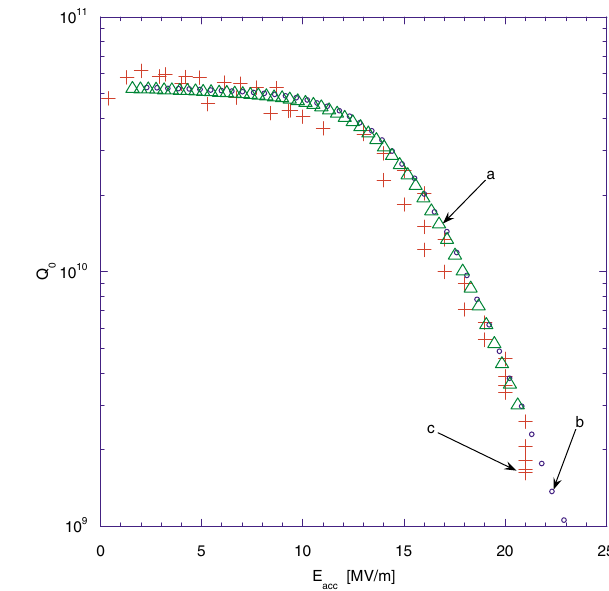
FIG. 13. (Color) Surface defect simulation for a 1500 MHz cavity. Curves are labeled as follows: ( a ) bath cooled, no surface defect; ( b ) bath cooled with surface defect; ( c ) five pipes ; (cid:15) 2 cm , surface coverage 38%, no defect; ( d ) same as ( c ) but with surface defect; ( e ) single pipe ; (cid:15) 7 : 1 cm , surface coverage 38%, no defect; ( f ) single pipe with surface defect.